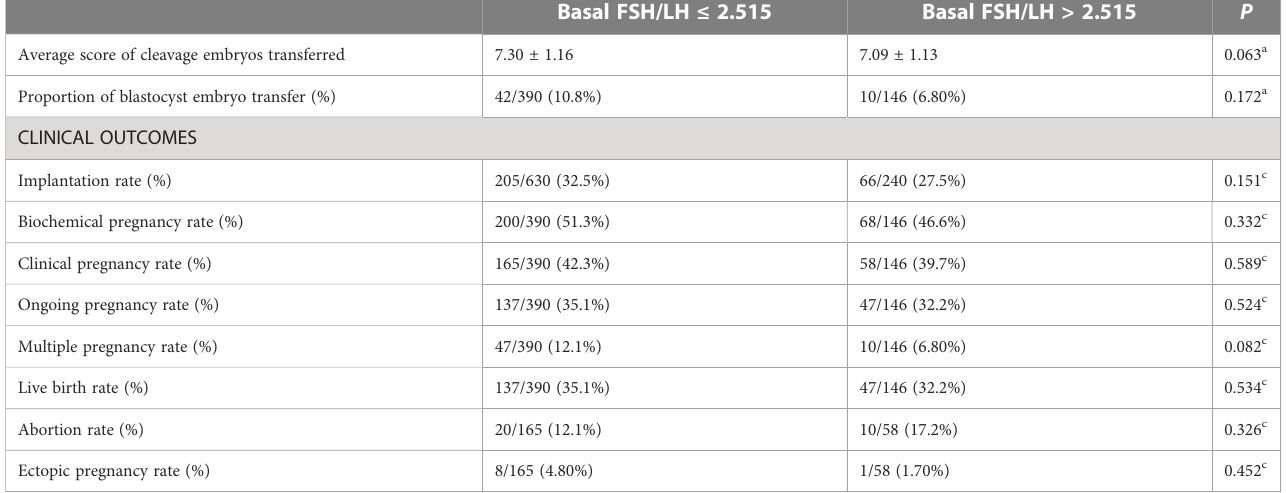
TABLE 4 Basic characteristic, embryological outcomes and clinical outcomes of subgroups based on SD6 FSH/LH ratio cutoff value for poor reproductive potential.